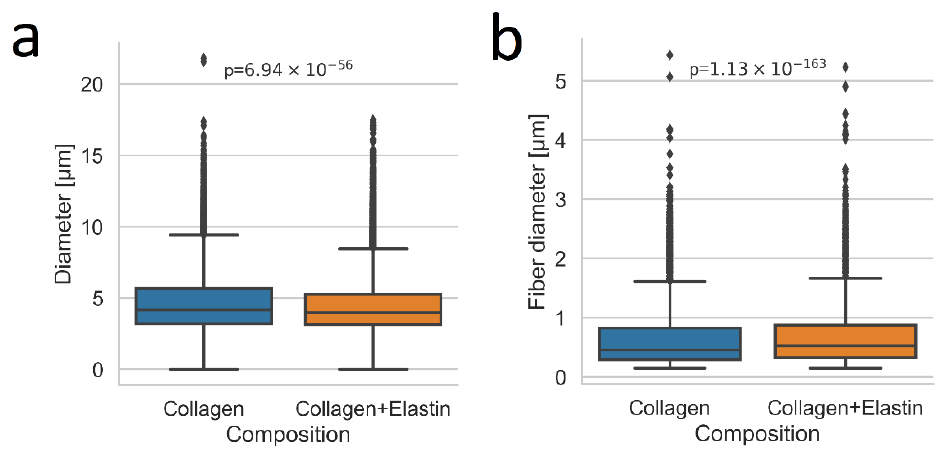
Figure 6. ( a ) Pore diameter of a 2 mg/mL collagen gel and a 33.3 w% elastin collagen gel. ( b ) Fiber diameter of the same gel. Ten positions for each condition were used and 100 planes were summed each prior to analysis. Significance was tested with the Mann – Whitney U test.